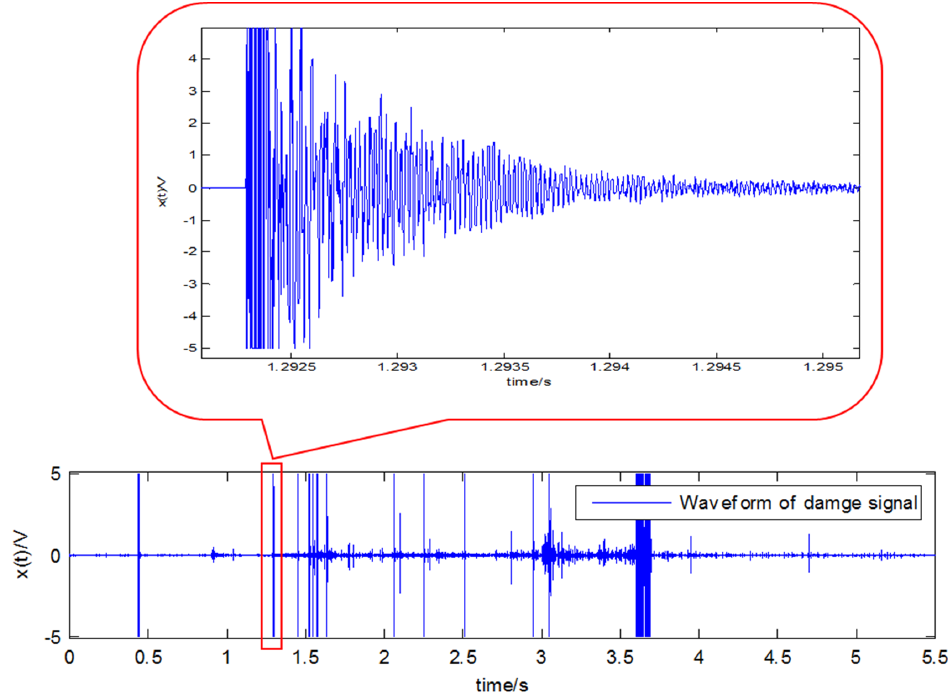
Figure 16. The damage signal waveform of sensor 1.